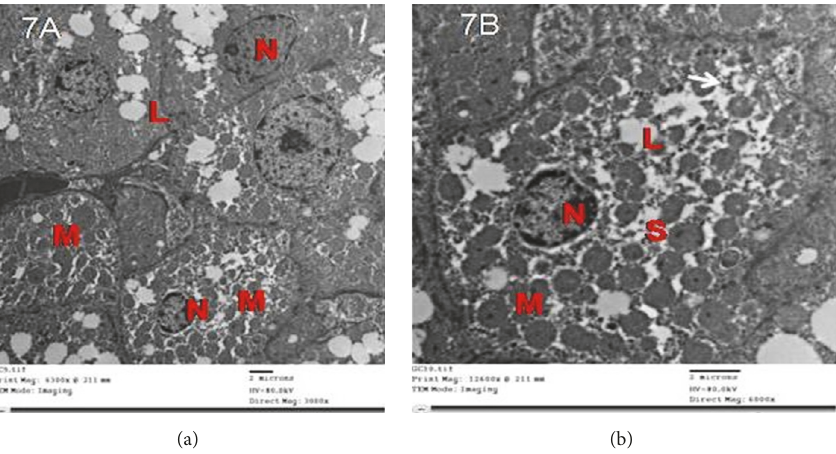
Figure 7: Electron micrographs of the adrenal cortex of a control group showing ZG cells with (a) spherical or irregular nuclei (N) with peripheral heterochromatin, numerous mitochondria (M), and few lipid droplets (L). (b) Irregular nuclei (N) with peripheral heterochromatin, many mitochondria (M), smooth endoplasmic reticulum (S), some lipid droplets (L), and free ribosomes (arrow).